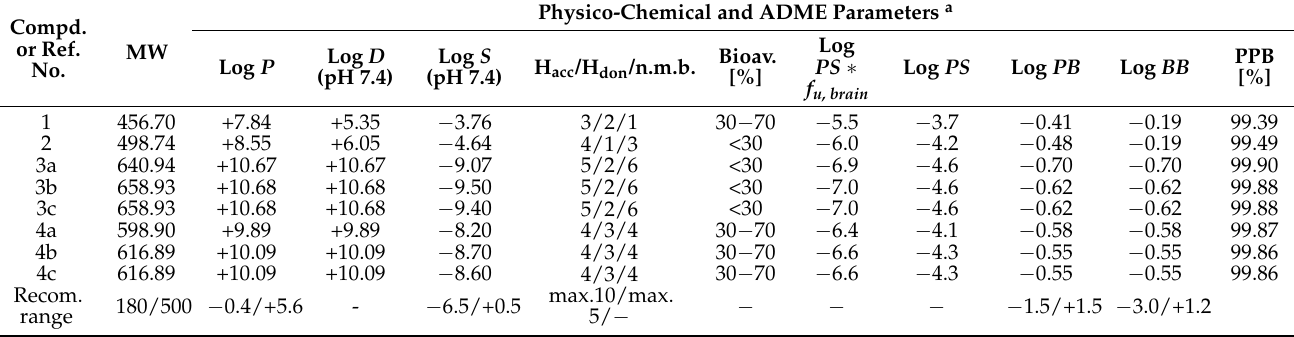
Table 2. Physico-chemical and ADME parameters of the target compounds 1, 2 and 3a–4c calculated using the ACD/iLabs software